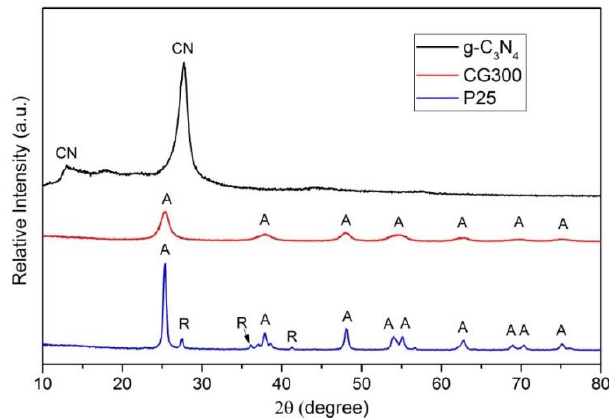
Figure 2. X-ray di ff raction (XRD) patterns of the tested nanomaterials. A—anatase, R—rutile, Figure 2. X-ray diffraction (XRD) patterns of the tested nanomaterials. A—anatase, R—rutile, CN—g-C 3 N CN—g-C 3 N 4.